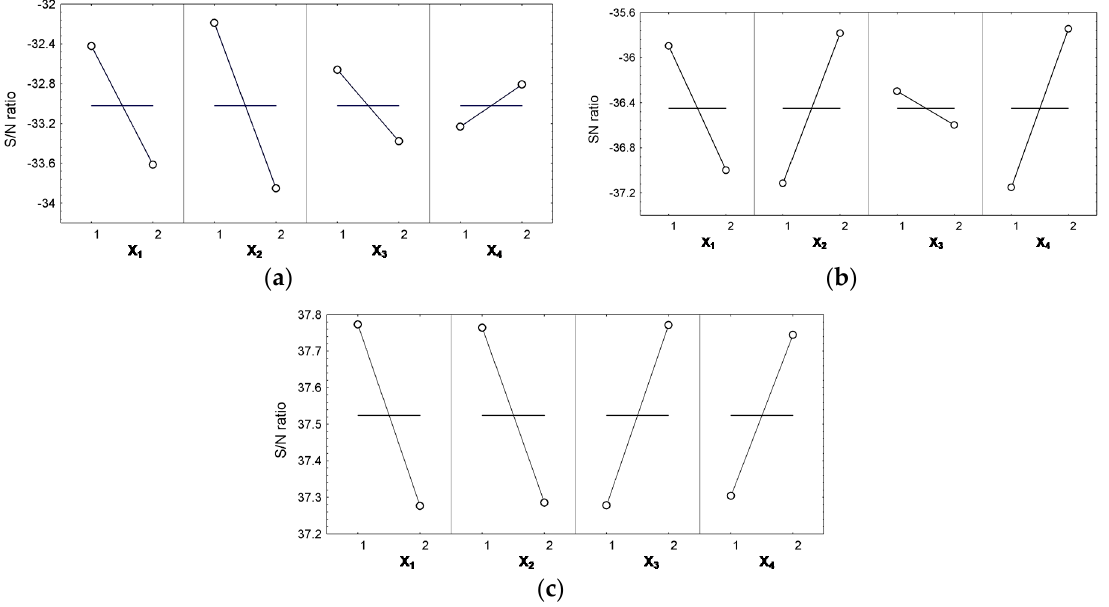
Figure 8. Control factors effects on S/N ratio for: ( a ) diameter ( Y 1 ), ( b ) enzymatic degradation at 2 h ( Y 2 ), ( c ) drug entrapment efficiency ( Y 3 ).